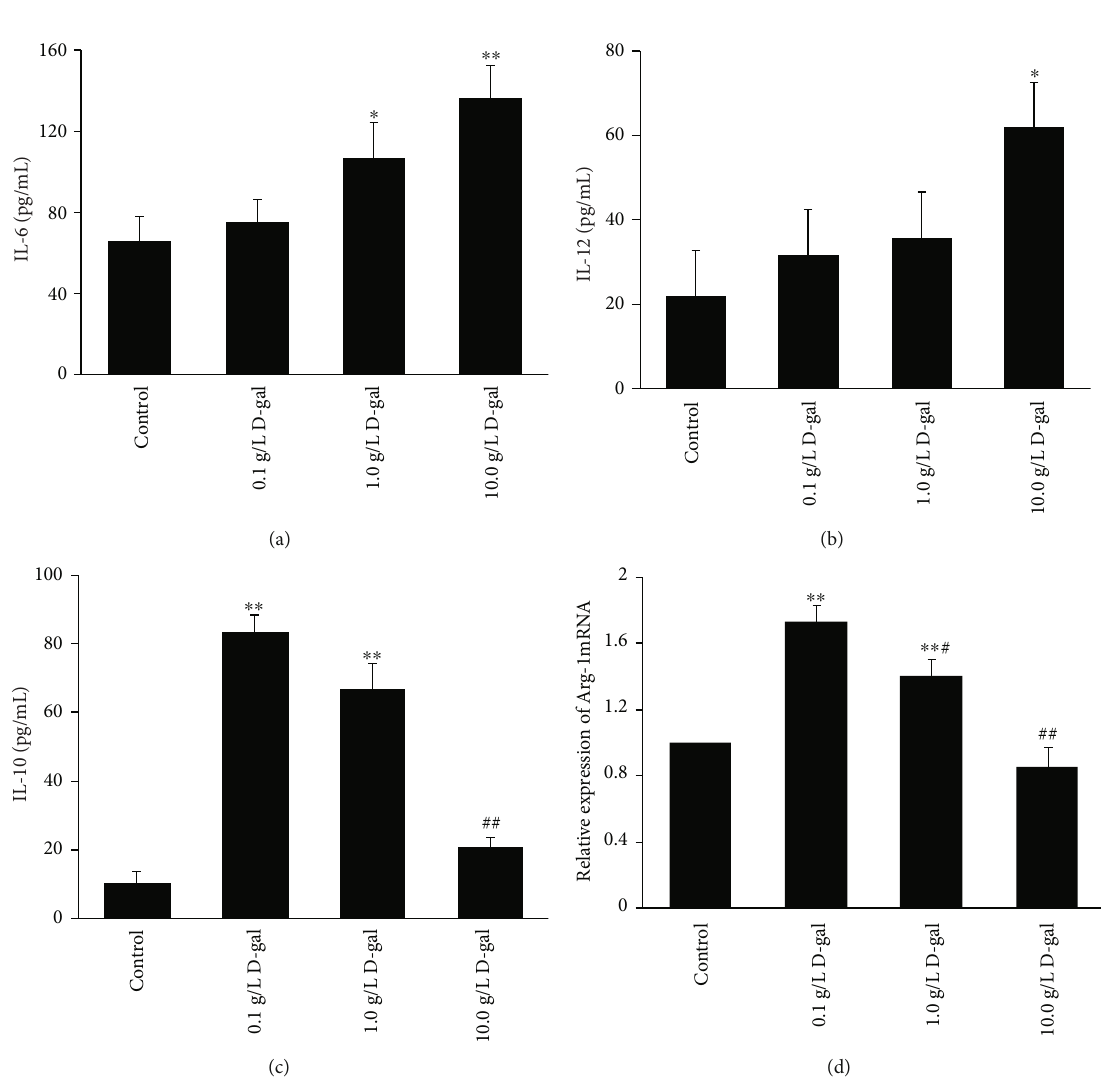
Figure 4: E ff ects of D-gal on polarity of J774A.1 macrophages. The IL-6 (a), IL-12 (b), and IL-10 (c) levels were assayed by ELISA. The results showed that the IL-6 concentrations in the 1.0 and 10.0g/L D-gal groups were signi fi cantly higher than those in the control group ( ∗ P < 0 : 05 , ∗∗ P < 0 : 01 , n = 3 ). The IL-12 concentrations in the 10.0g/L D-gal group increased compared with those in the control group ( ∗ P < 0 : 01 , n = 3 ). The IL-10 level increased in the 0.1, 1.0, and 10.0g/L D-gal groups compared with that in the control group ( ∗ P < 0 : 05 , ∗∗ P < 0 : 01 , n = 3 ). However, the IL-10 level in the 10.0g/L D-gal group signi fi cantly decreased compared with that in the 0.1g/L D-gal group ( ## P < 0 : 01 , n = 3 ). (d) qPCR analysis of the relative expression level of Arg-1 mRNA. GAPDH was used as an internal control. The Arg-1 mRNA expression level in the 1.0 and 10.0g/L D-gal groups was gradually lower than that in the 0.1g/L D-gal group ( # P < 0 : 05 , ## P < 0 : 01 , n = 3